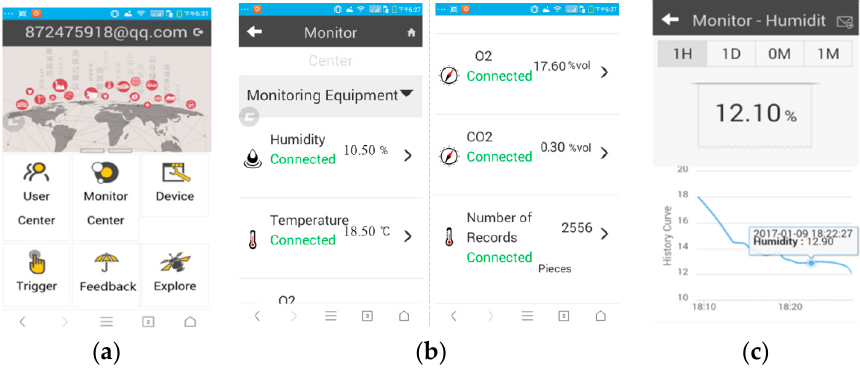
Figure 10. Screenshot of the software interface of mobile version: ( a ) software homepage; ( b ) monitoring center screenshot; and ( c ) information processing